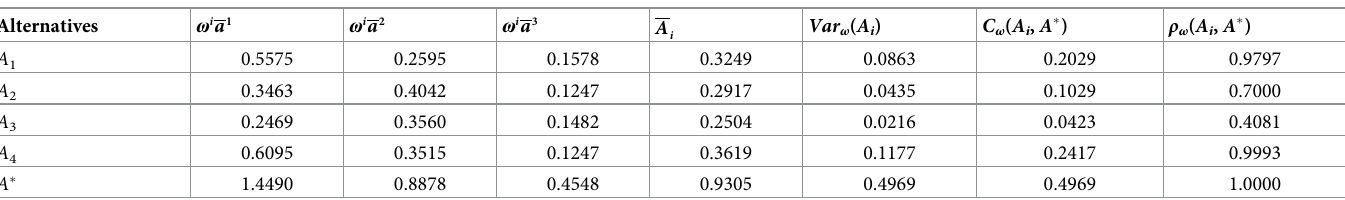
Table 2. Calculation results with respect to the given weights.